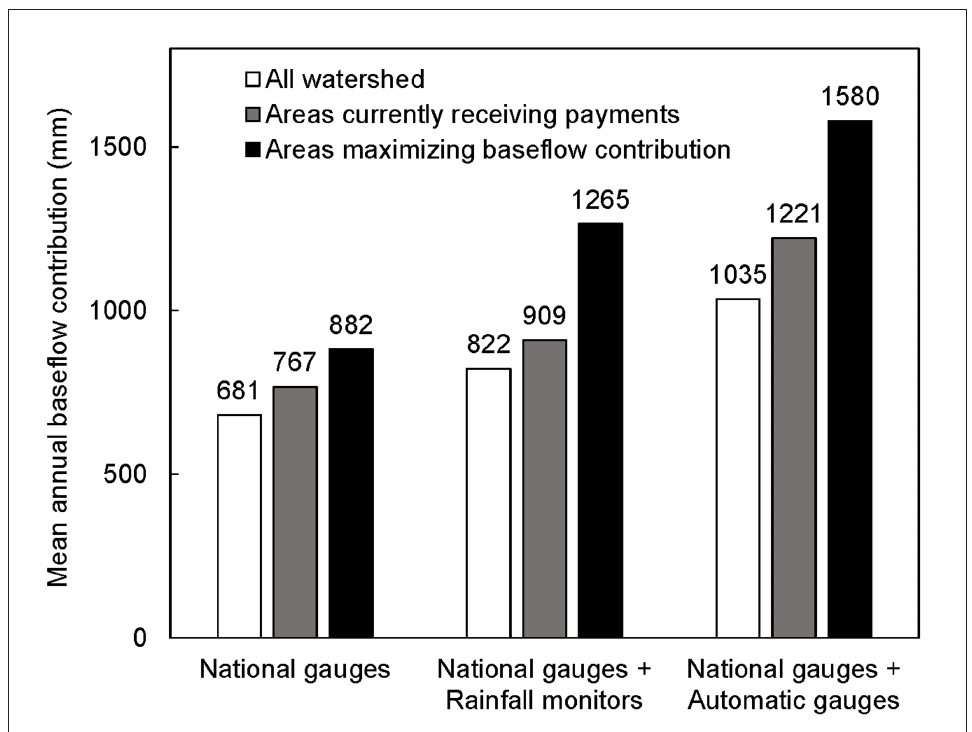
Figure 5: Average baseflow contributions for the whole watershed area, for the areas receiving payments, and for the total payment area applied to the maximum baseflow areas for the Soil Water Assessment Tool (SWAT) simulations as measured by national climate stations alone, the volunteer rainfall data plus the national climate stations, and the automatic gauge data plus the national climate